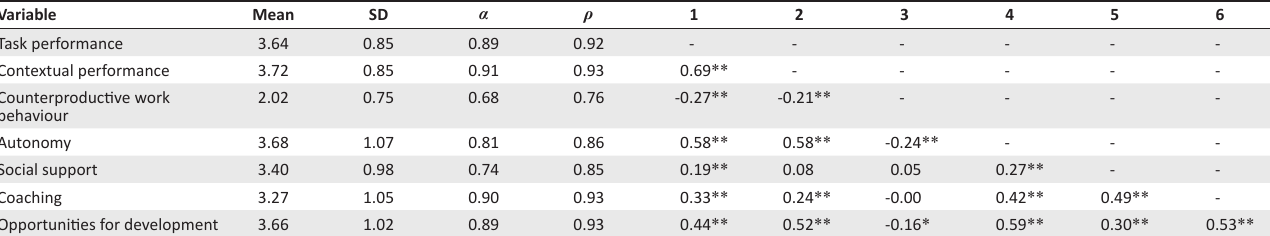
TABLE 3: Means, standard deviations, reliability and correlations.